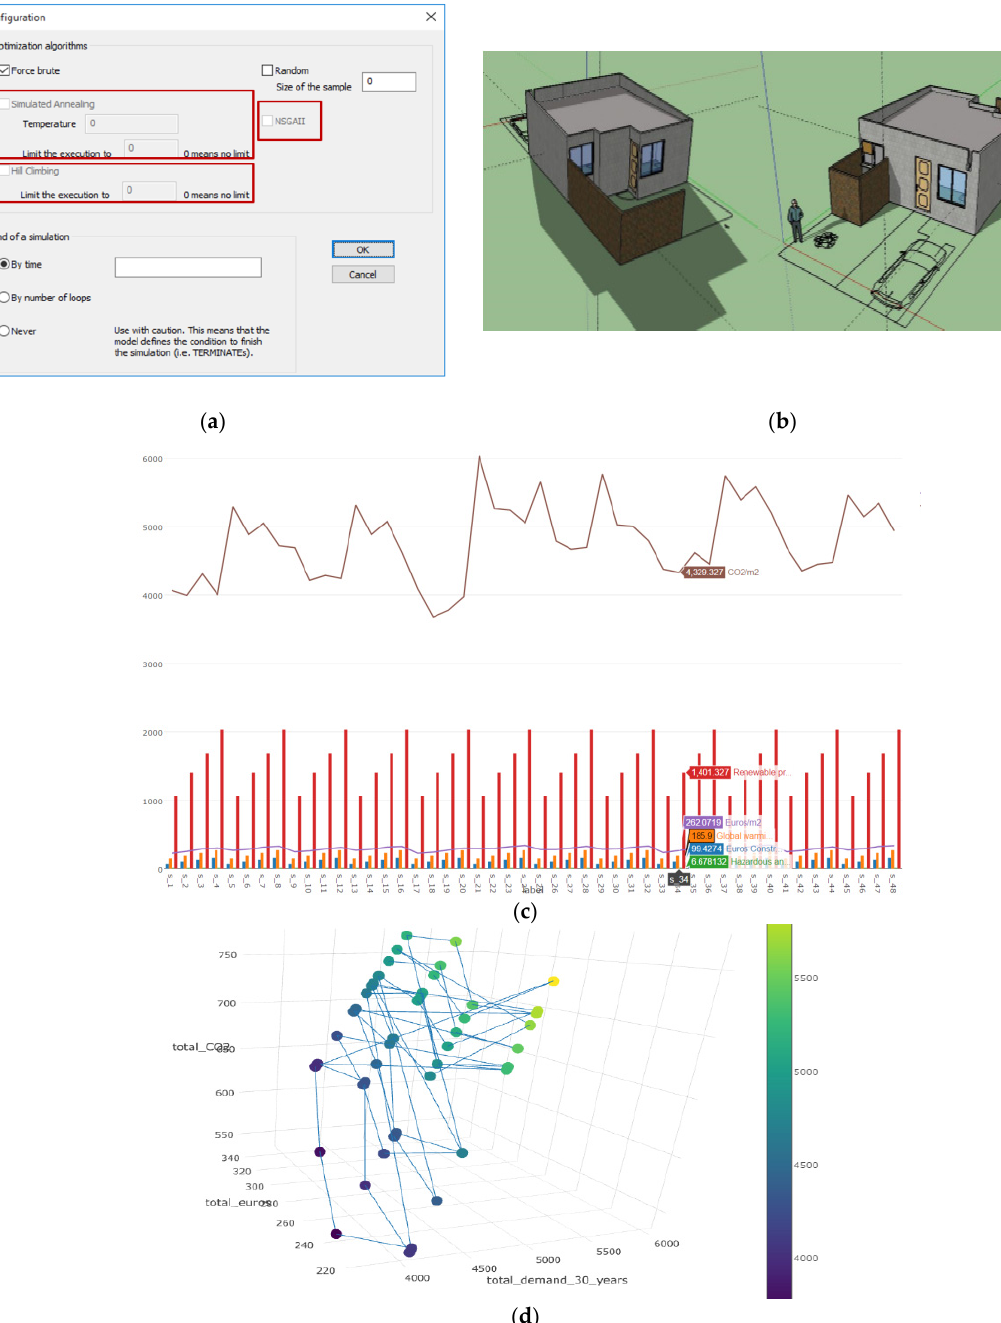
Figure 10. Case study no. 2 for expressing use of BIM in energy modeling: individual house in Skopje, North Macedonia. ( a ) Configuration of geographical location; ( b ) conceptual design from BIM model and checking for solar radiation and shadowing and first visual checker of PV and solar paneling location; ( c ) actual energy consumption and environmental impacts calculated with BEM; ( d ) estimated predictions for future building performance using